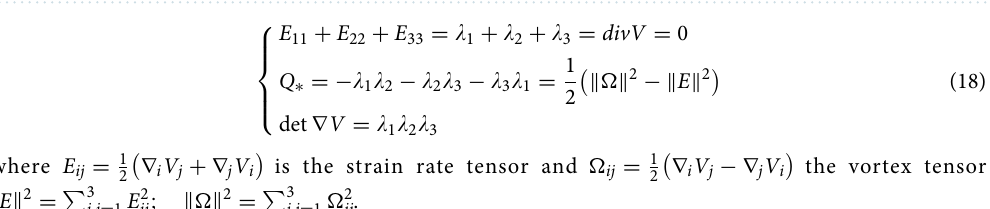
Figure 19. Vortex distribution in the middle section of the pump as turbine during medium-speed start-up (s −2